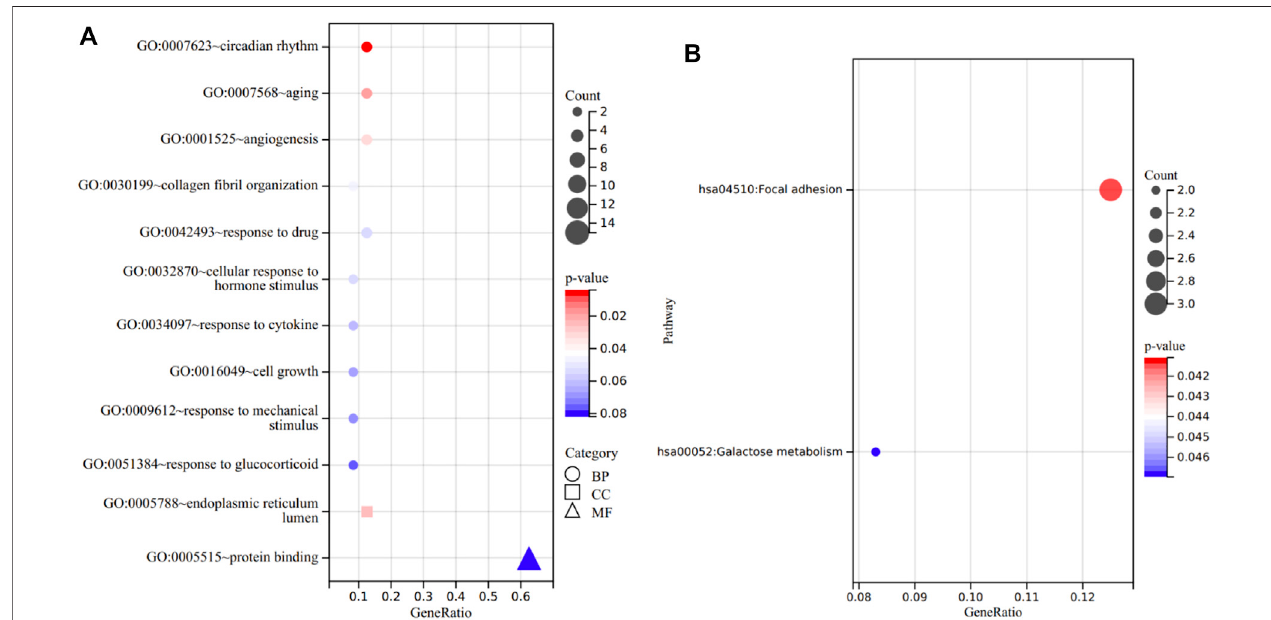
FIGURE 6 | Functional annotation of the 24 overlapping genes. (A) The enriched terms in GO analysis. (B) KEGG analysis.